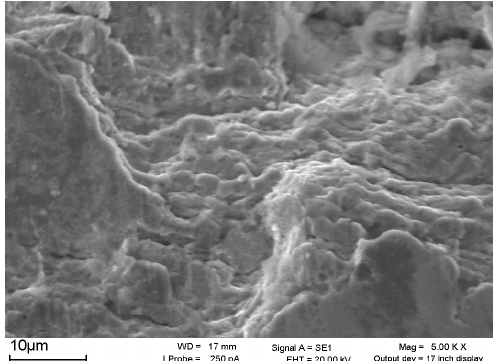
Figura 12: Rottura a fatica di zone perlitiche in un acciaio EN 34CrMo4 legato con B, temprato e rinvenuto. Regione di cuore di una barra di 90 mm di diametro. Figure 12: Fatigue fracture of pearlite zones formed in a quenched and tempered EN 34CrMo4, B alloyed, steel component. Core region of a 90 mm dia. bar.